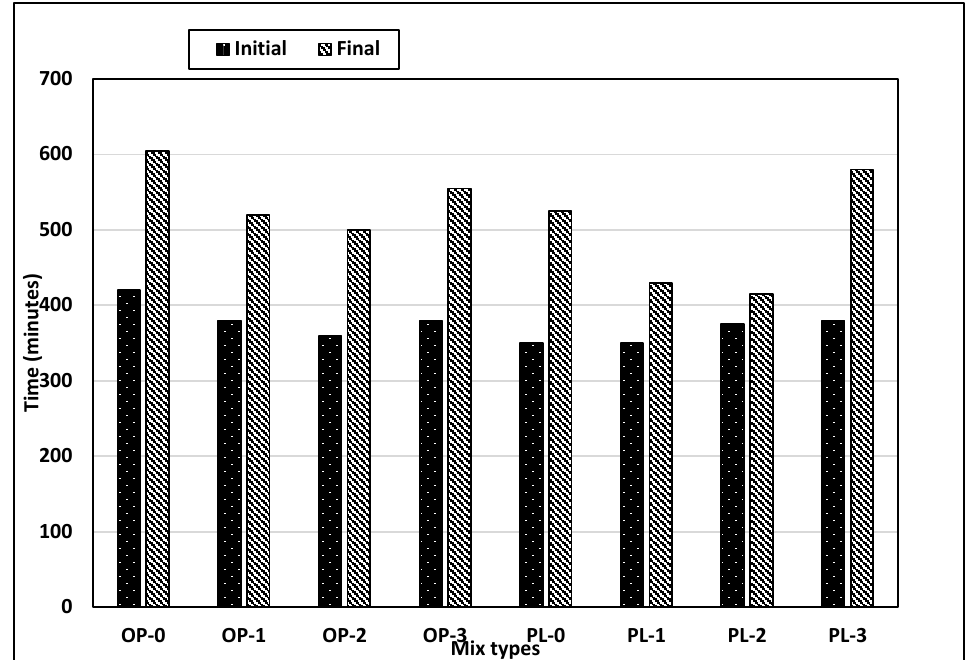
Figure 5. Results of setting test for all mixes.